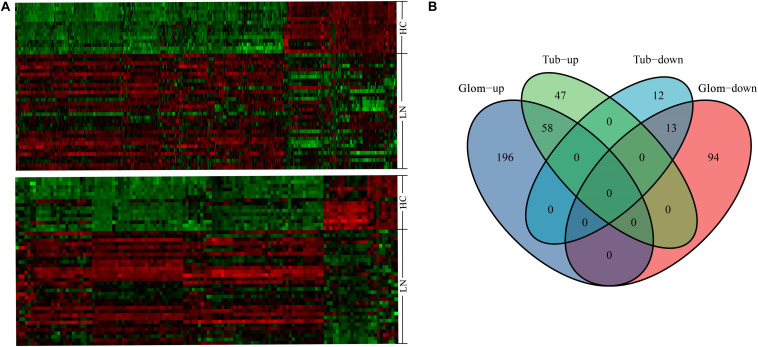
The hierarchical clustering heat maps and Venn diagrams. (A) The heat map above represents the differentially expressed genes (DEGs) in glomeruli; the heat map below represents the DEGs in tubulointerstitia; red represents upregulation and green represents downregulation. (B) The Venn diagram of the upregulated genes and downregulated genes in glomeruli and tubulointerstitia. LN, lupus nephritis; HCs, healthy controls; Glom, glomeruli; Tub, tubulointerstitia.